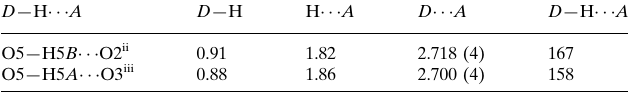
Hydrogen-bond geometry (A˚ , (cid:3)